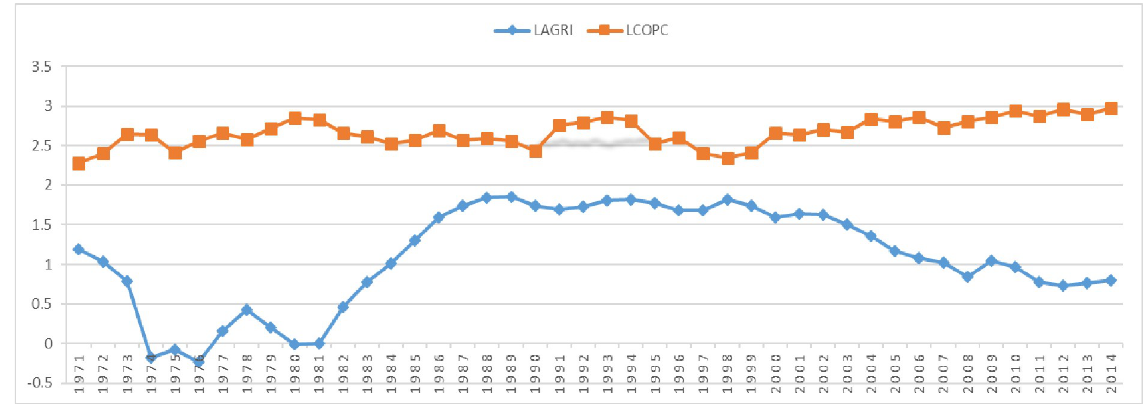
Fig 1. Trends of LARGI t and LCOPC t